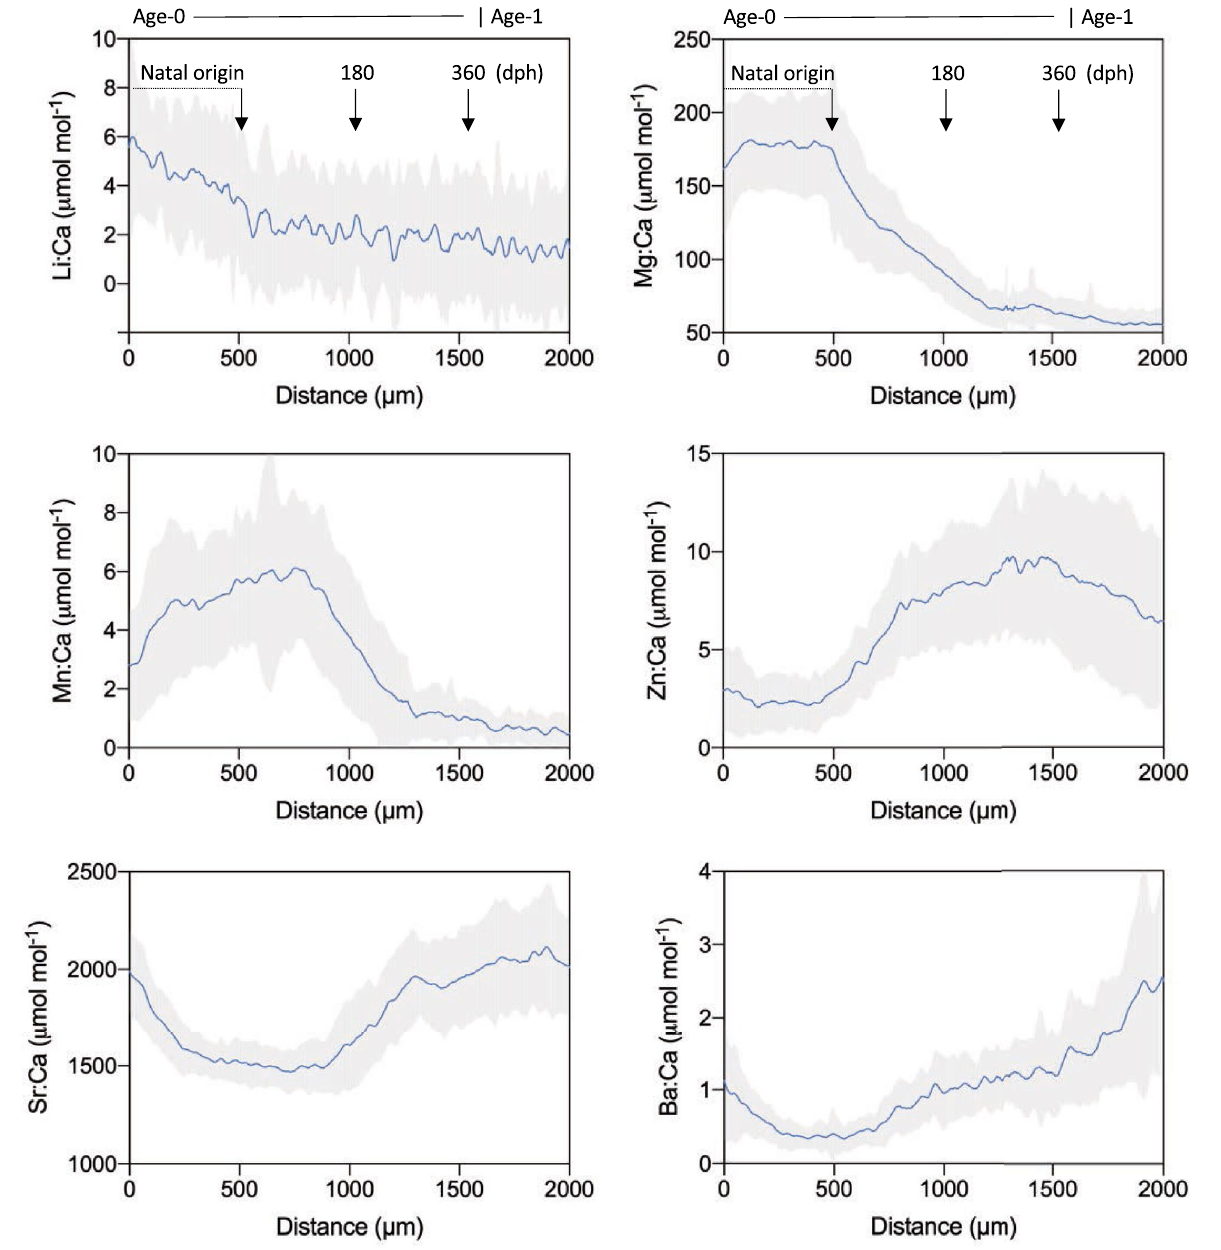
Figure 3. Mean geochemical profiles developed using element:Ca data from all Pacific bluefin tuna collected from the Ryukyu Archipelago in the East China Sea (N = 56, Table S2). Mean profiles shown separately for each of the six element:Ca ratios (Li:Ca, Mg:Ca,m Mg:Ca, Zn:Ca, Sr:Ca, Ba:Ca) along the laser path from the otolith core to 2000 µm. Blue lines represent mean values and shading denotes 1 SD. Area of laser path used to estimate natal origin (0–500 µm) is denoted; location on geochemical profile corresponding to 180 and 360 days post hatch (dph) is also